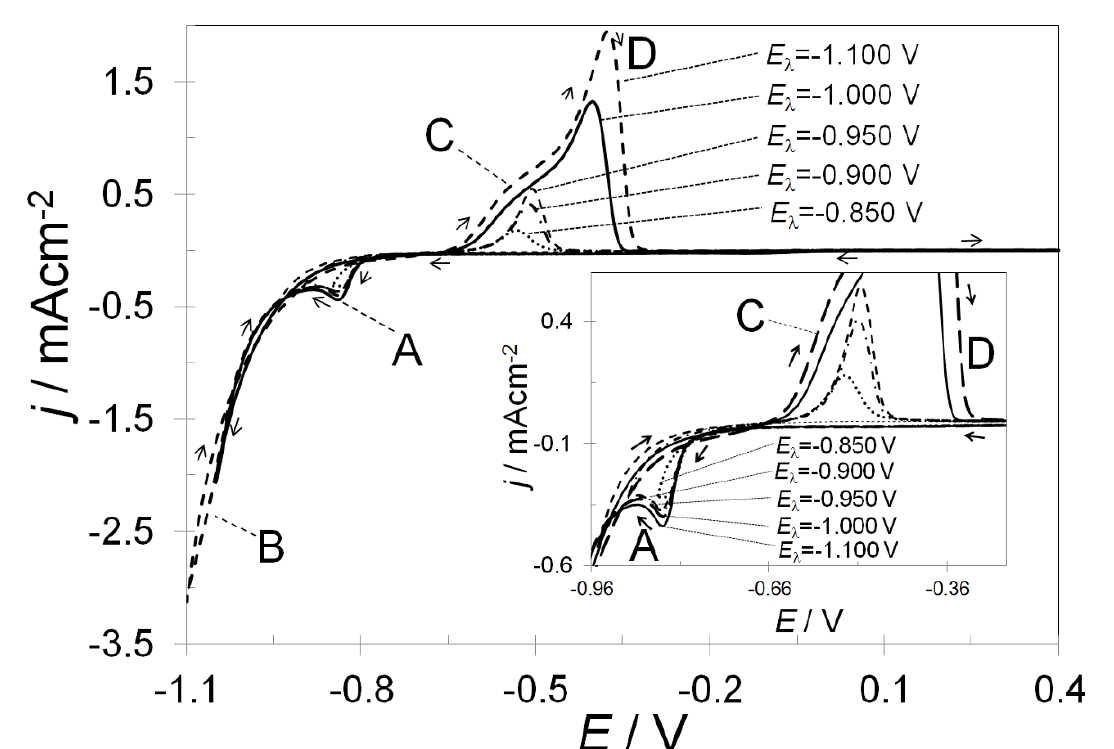
Figure 2. Cyclic voltammograms obtained in the system 0.01M CoSO the potential scan started at 0.600 V towards the negative direction with a potential scan rate of 20 mV s -1 . Arrows indicate the potential scan direction. Cathodic and anodic density peak currents are indicated.